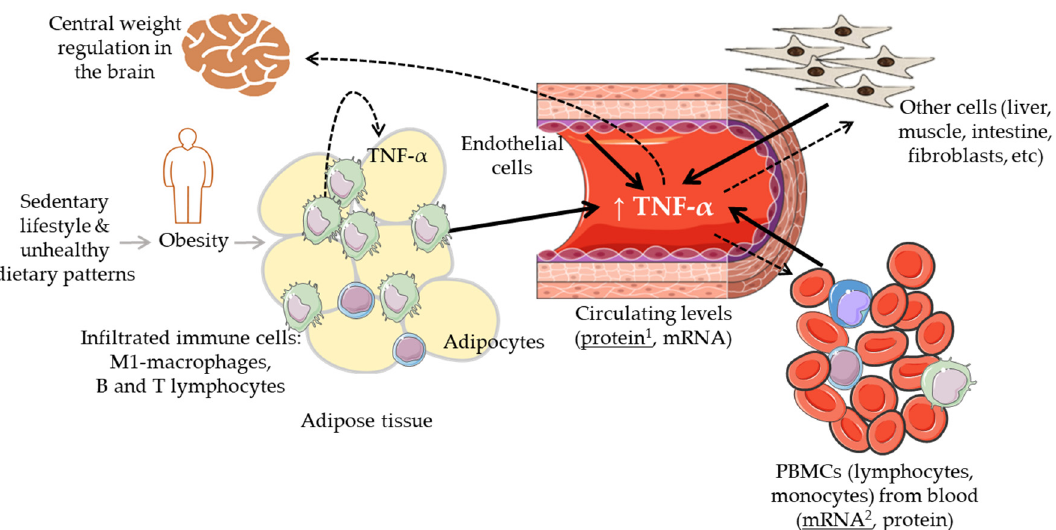
Figure 1. Graphic summary of the biological regulatory scenario of the levels of TNF- α in the context of body weight alterations. Solid black arrows indicate different cells and tissues that can contribute to the circulating levels of TNF- α ; dashed arrows indicate different tissues where TNF- α can have a regulatory effect. 1 : TNF- α protein levels most commonly measured in blood (serum, plasma); 2 : TNF- α mRNA levels most commonly measured in peripheral blood mononuclear cells (PBMCs).